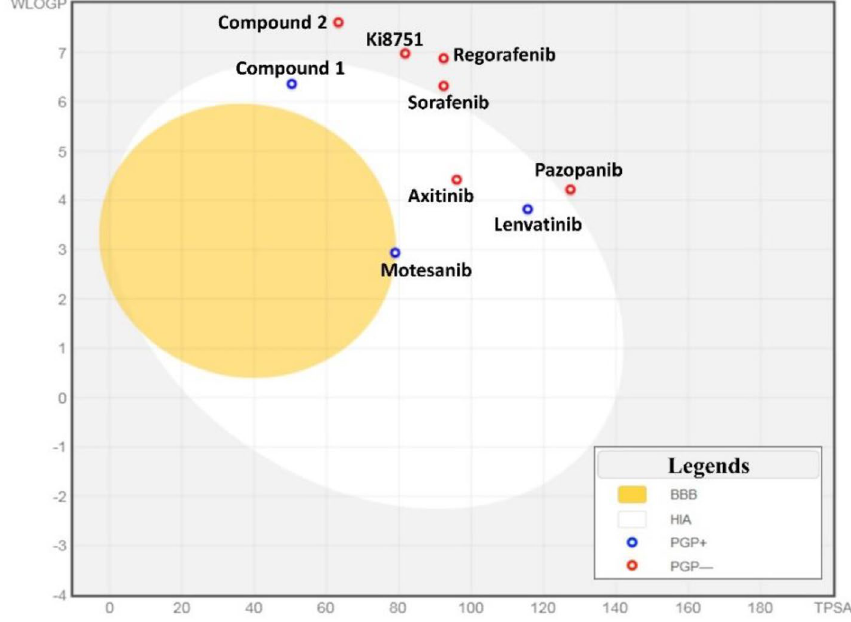
Figure 7. Predicted BOILED-Egg graph for intuitive evaluation of brain access (BBB) and gastrointestinal absorption (HIA) of 7 known inhibitors of VEGFR2 and 2 candidate compounds (molecule1 and molecule2). The result is based on lipophilicity (WLOGP) versus Topological polar surface area (TPSA). The figure is created by using SwissADME platform, www. swiss adme. ch.